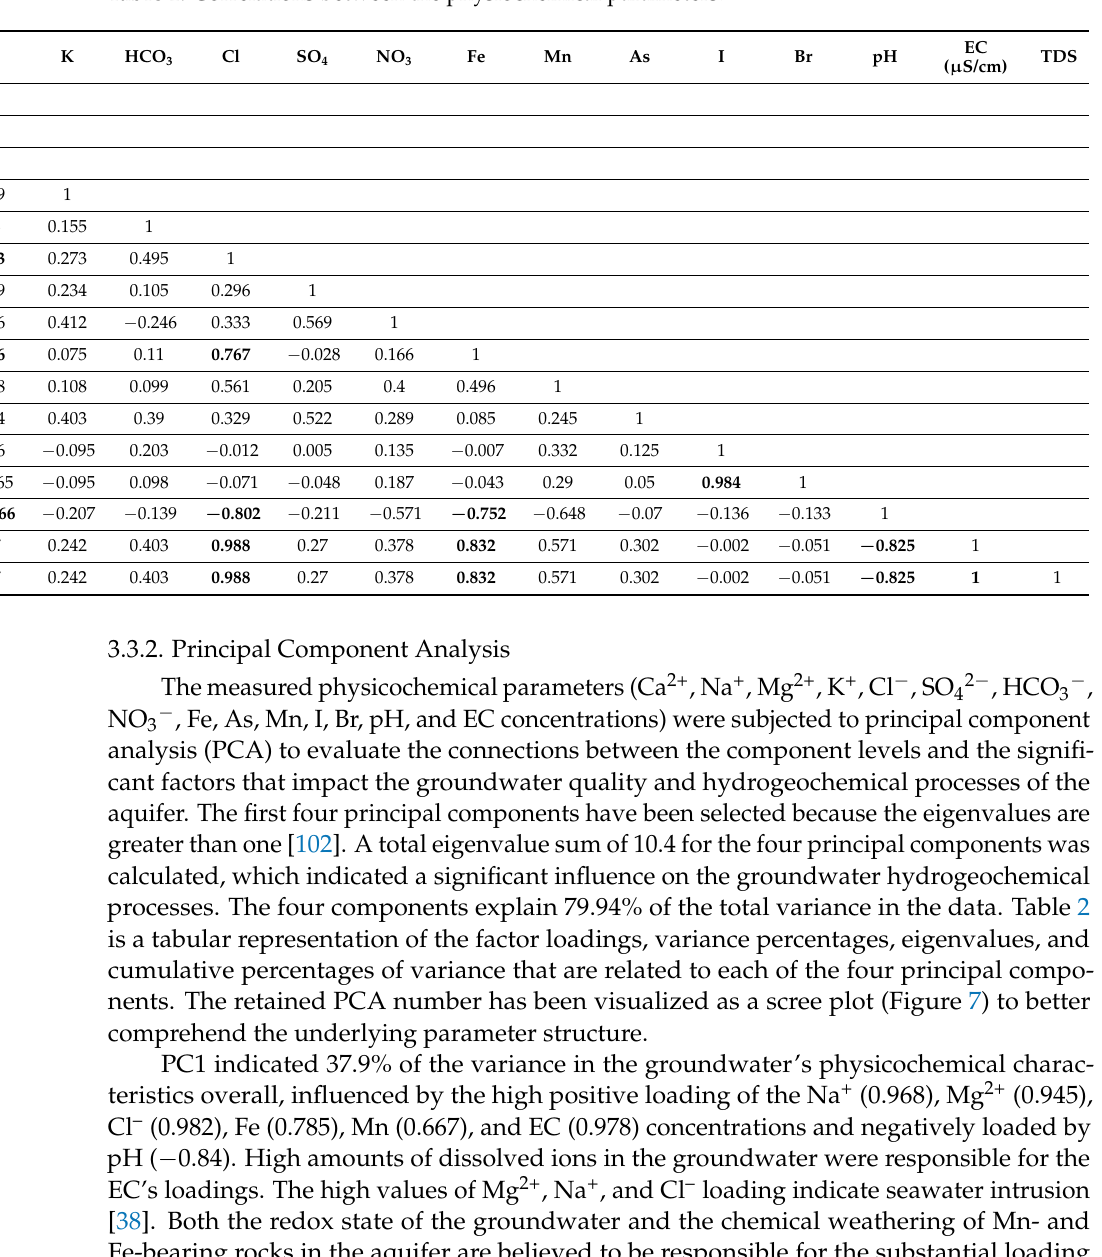
Table 1. Correlations between the physiochemical